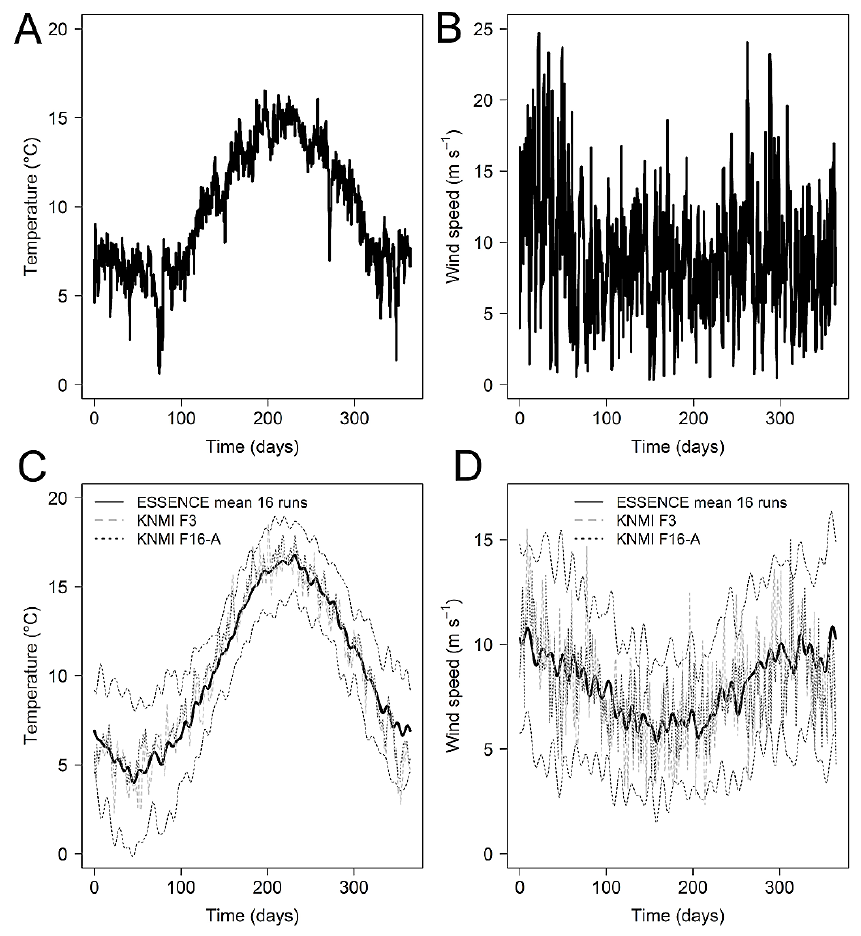
Fig. 3. Hourly temperature (A) and wind (B) data generated by the ESSENCE climate model (simulation run 2 for year 2010). Bottom panel shows a comparison between the simulations of the ESSENCE simulations (mean of 16 different simulation runs) (black solid line) and data from the F3 (dark grey solid line) and F16 (light grey solid line) station in the North Sea for the daily averaged temperature (C) and daily averaged wind speed (D) for the period 2007–2010. The 95% confidence interval of the ESSENCE simulations is indicated with the black dotted